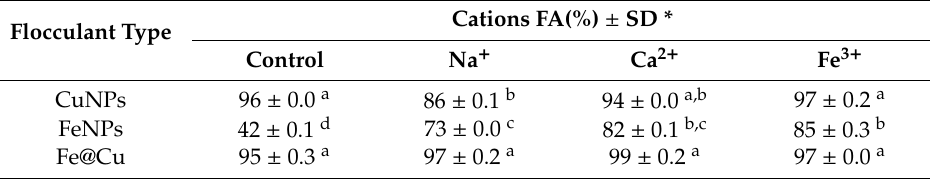
Table 1. E ff ect of cations presence on the flocculation activity at room temperature.